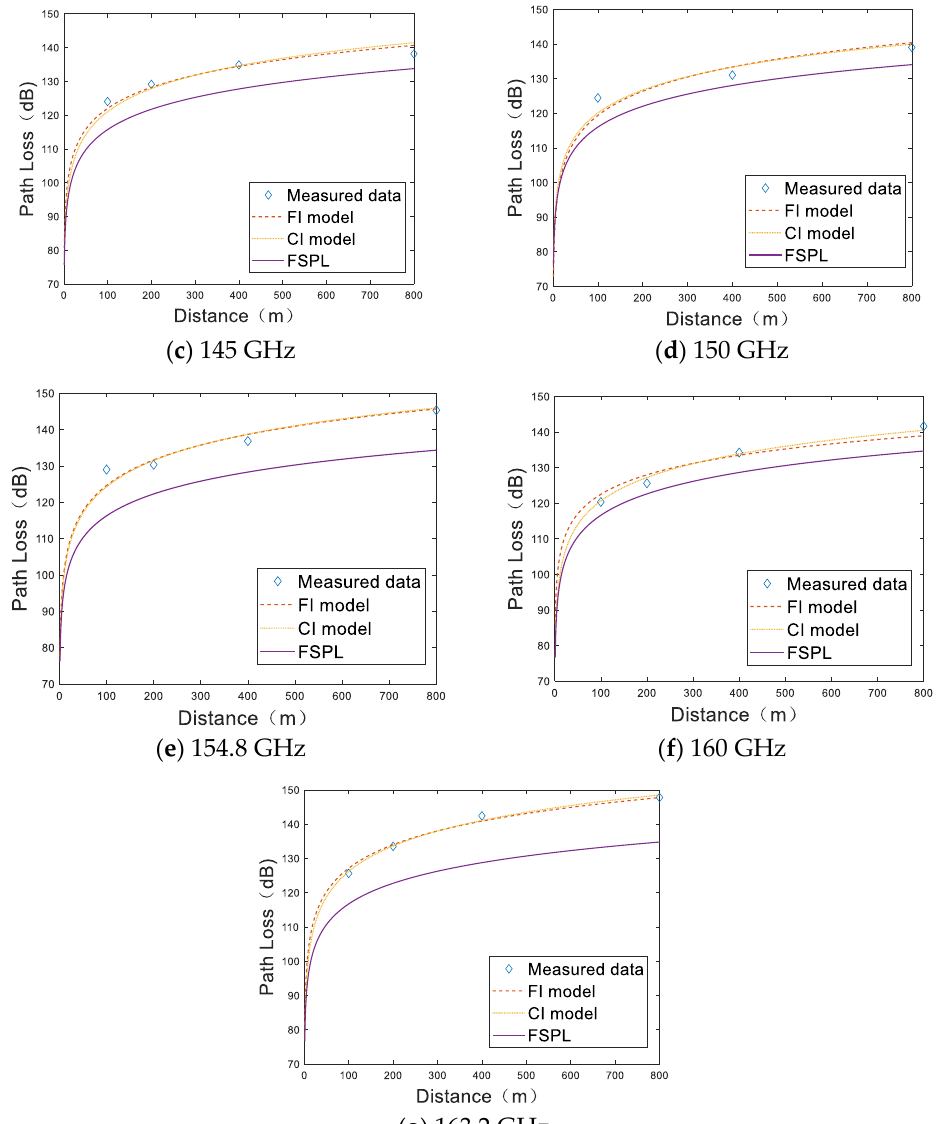
Figure 5. Path loss at 7 frequency points. The diamond represents the path loss sample at a certain distance, and the dotted, dot, and solid lines represent the FI, CI, and FSPL models, respectively. ( a ) 138 GHz; ( b ) 139.2 GHz; ( c ) 145.2 GHz; ( d ) 150 GHz; ( e ) 154.8 GHz; ( f ) 160.8 GHz; ( g ) 163.8 GHz.